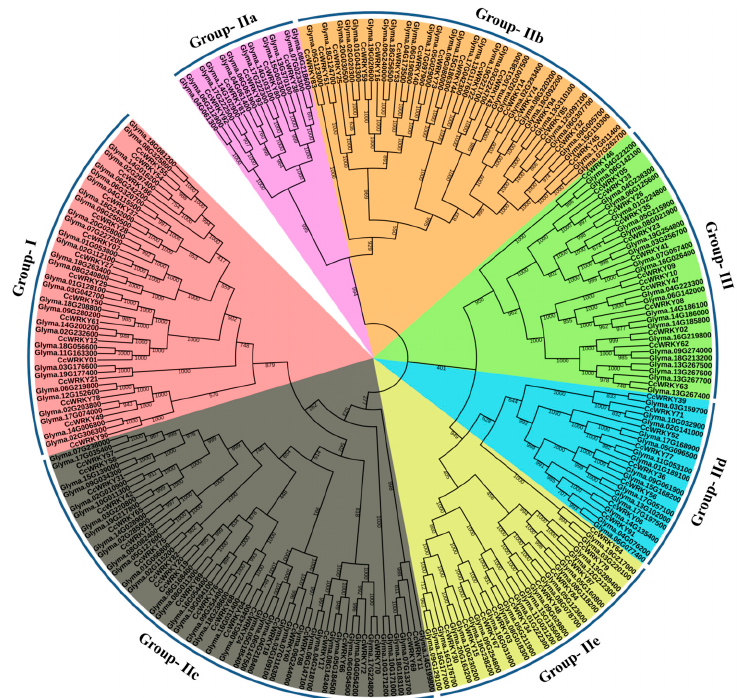
Figure 1. Unrooted phylogenetic tree of 267 WRKY proteins including 94 WRKY proteins from pigeonpea and 173 from soybean. Full-length amino acid sequences of WRKY from pigeonpea and soybean were aligned with Clustal X, and the phylogenetic tree was generated by the neighbor-joining method with 1000 bootstrap replicates using MEGA 7.0 software tool.